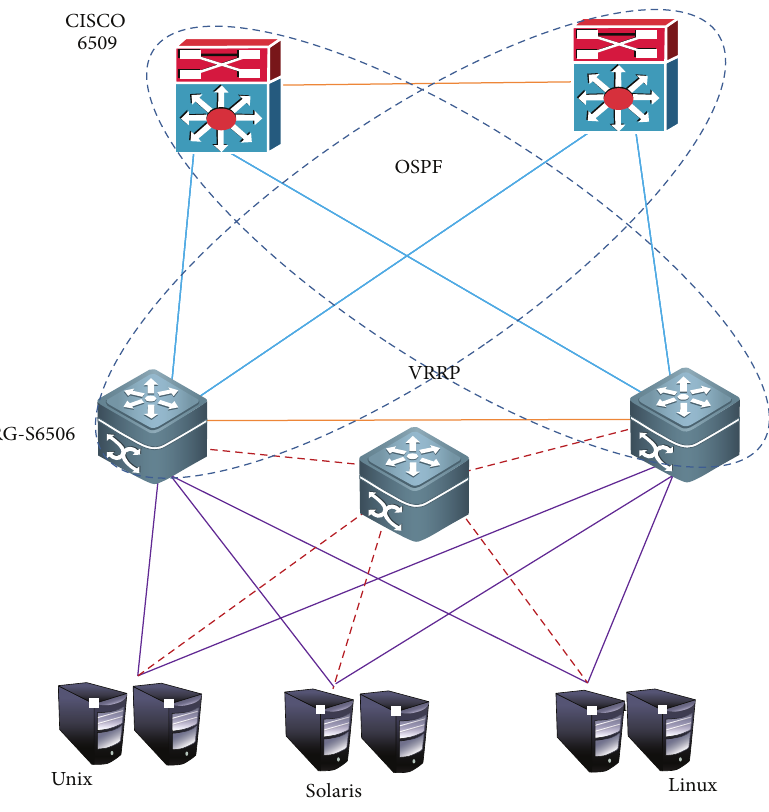
Figure 1: The topological structure of the network servers.